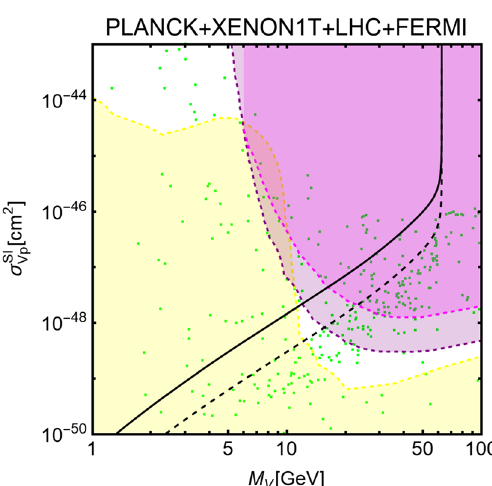
constraints, with the customary color code, for two benchmark examples of the dark SU(3) model in the regime M Ψ < M V 3 , M V with Ψ being not stable on cosmological scales. The results are shown in the ( M V , ˜ g ) plane while the other parameters have been kept fixed to the values reported on top of the panels